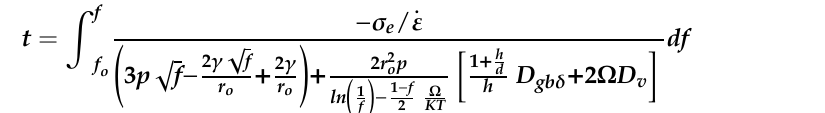
Figure 4. Relationship between the width of the reaction layer and bonding time for Ti-6Al-4V and magnesium Az31 [17].